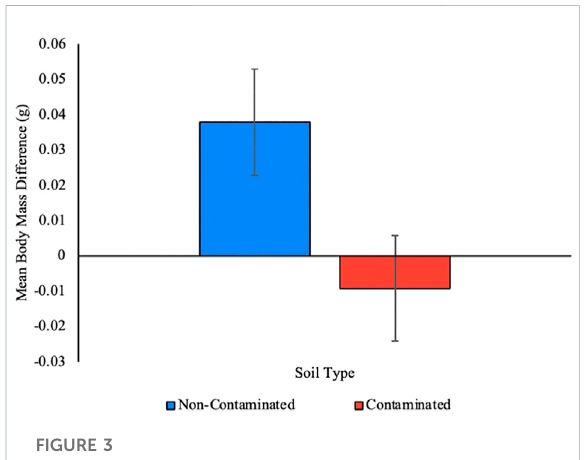
FIGURE 3 The impact of soil contamination on earthworm body mass. Living in contaminated soil for a week causes a slight loss in body masswhilelivingincleansoilcausesaslightgain,onaverage.Error bars represent the standard error of the means. p < 0.05.